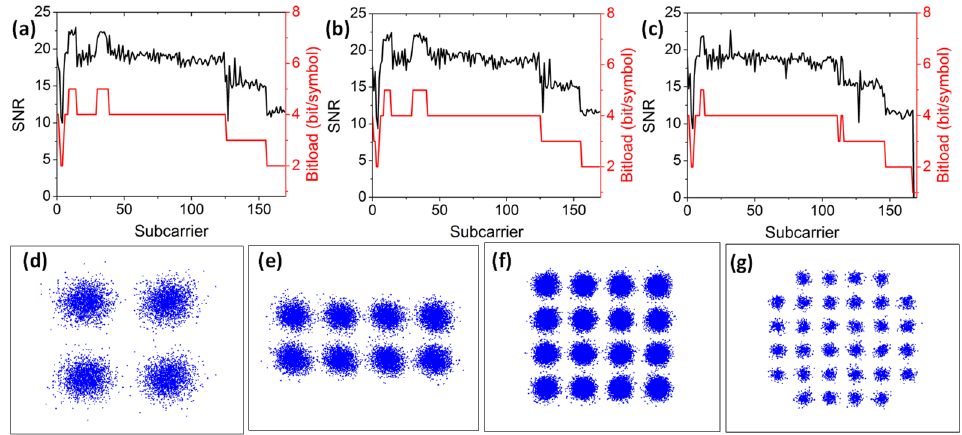
Figure 10. Measured BER curves of some selected wavelength channels of the 3 modes 3 dB optical power divider at ( a ) TE 0 , ( b ) TE 1 and ( c ) TE 2 modes.